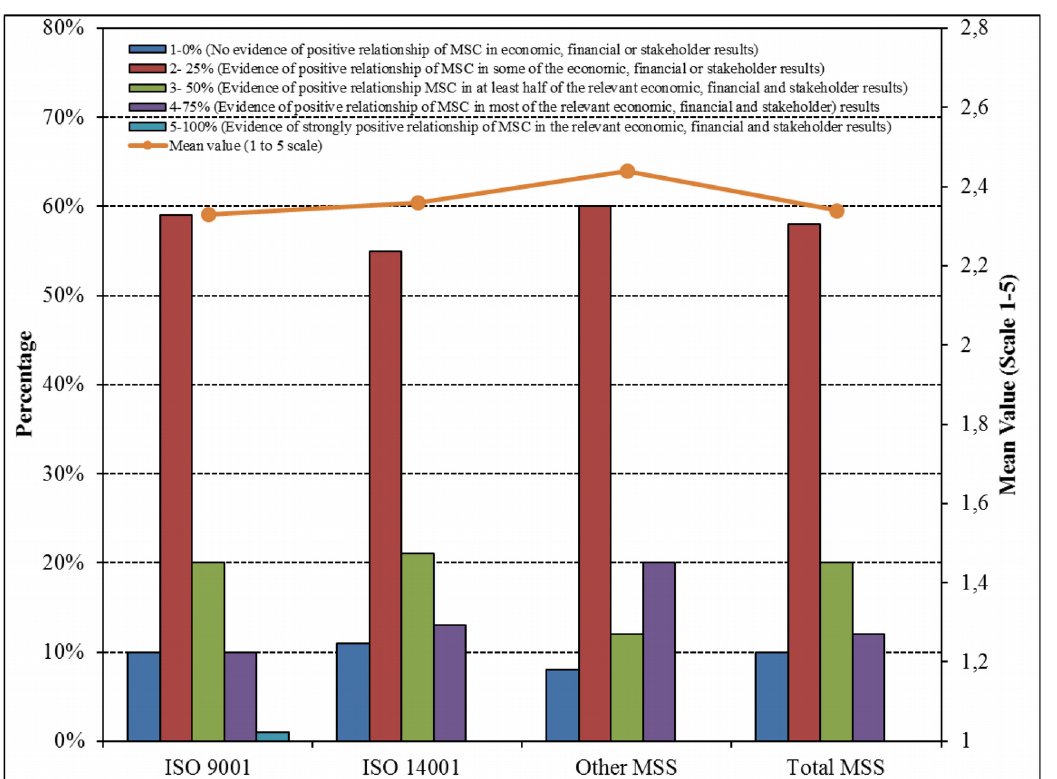
Figure 11. Results of the analysis of the relationship between Management Systems